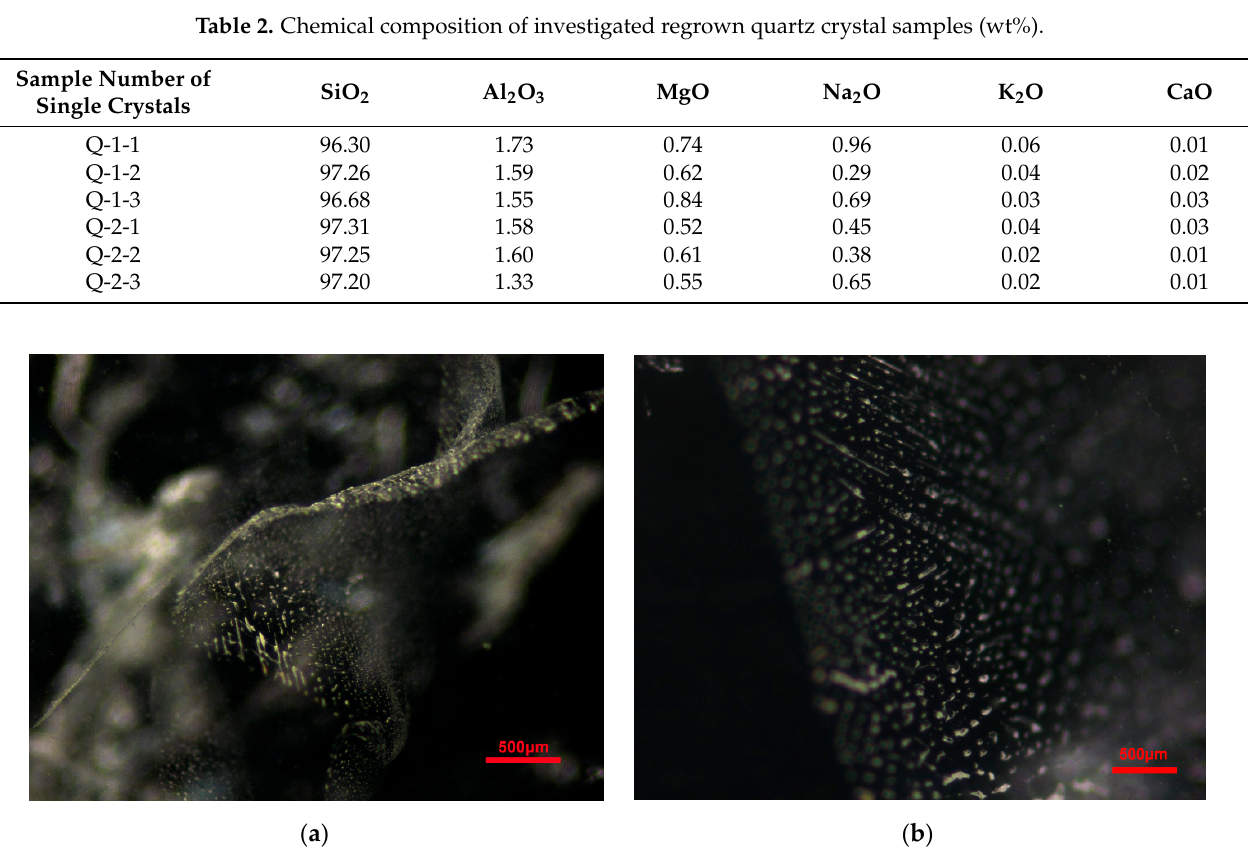
Figure 2. Typical gas-fluid inclusions in the regrown quartz crystal.